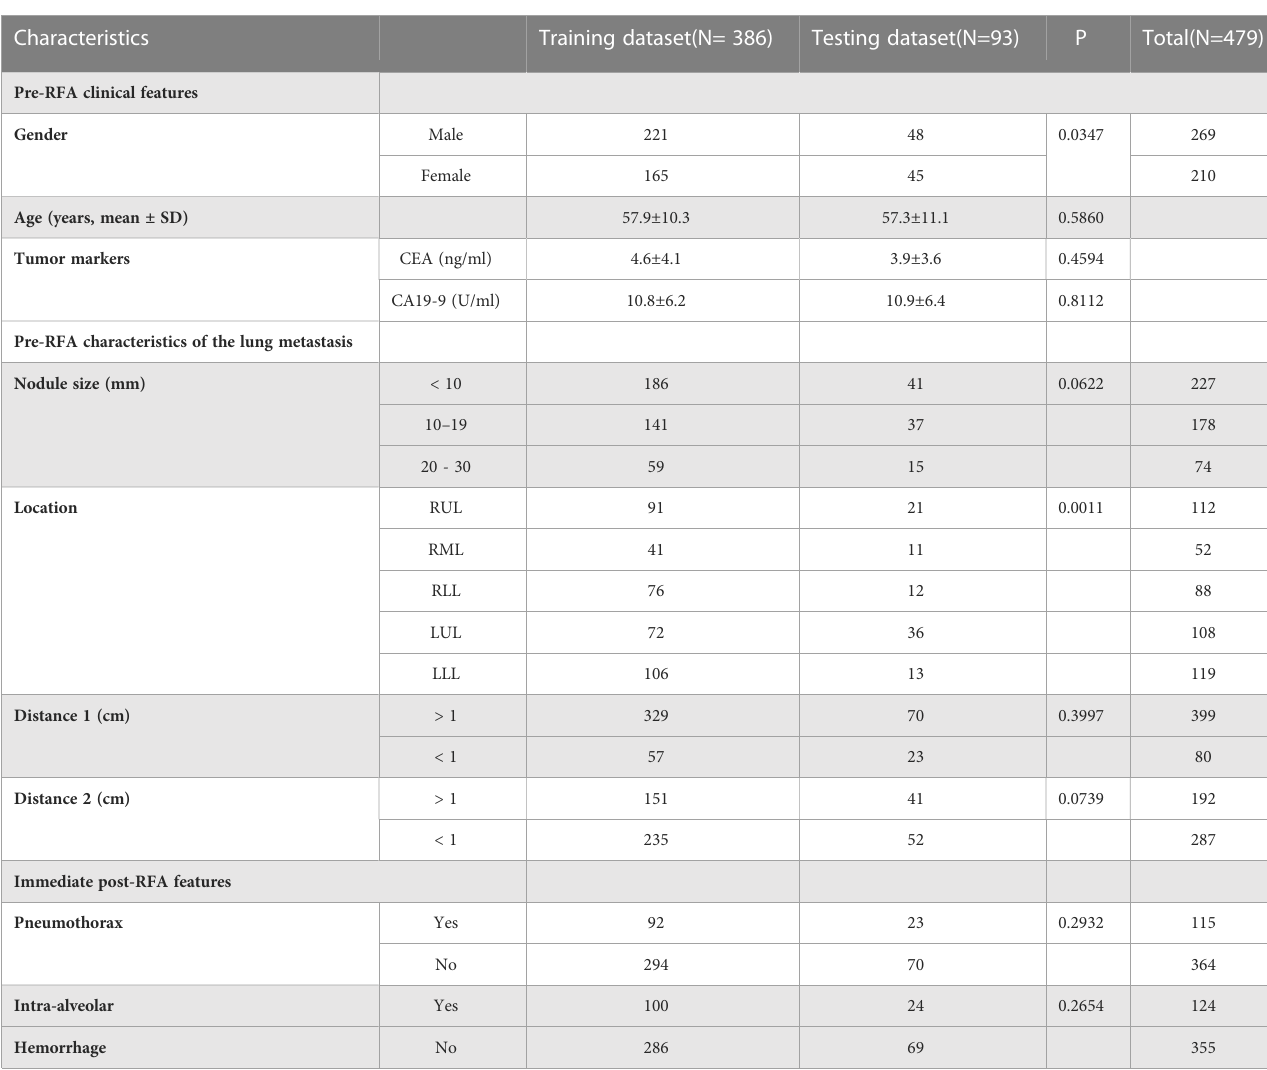
TABLE 1 Characteristics of patients and colorectal cancer lung metastases.